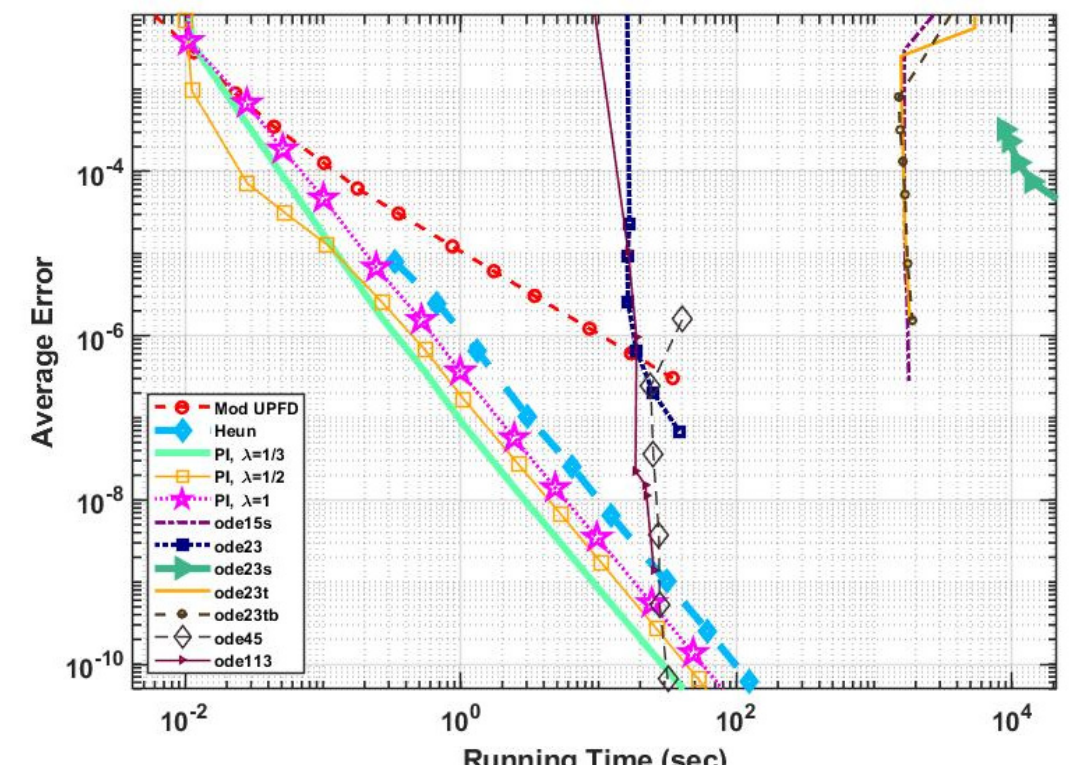
Figure 6. (average) errors as a function of the running time for the second (very stiff) system, in the case of the new algorithms and some other methods. Table 2. Comparison of different algorithms for the very stiff system of ten thousand cells.